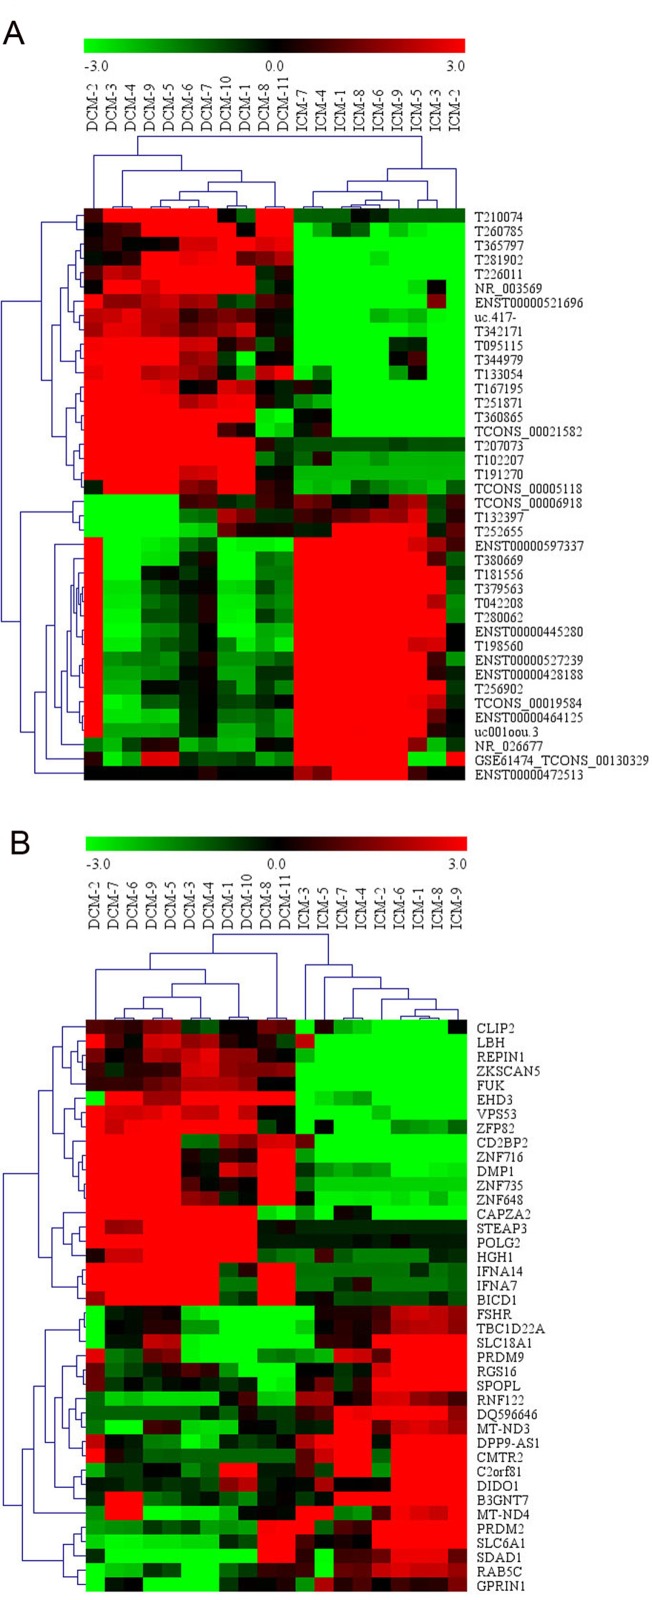
The heat map and hierarchical clustering analysis of long noncoding RNAs (lncRNAs) (A) and messenger RNAs (mRNAs) (B) that were differentially expressed between the peripheral plasma samples from dilated cardiomyopathy (DCM) and ischemic cardiomyopathy (ICM) patients. Top 20 upregulated and top 20 downregulated results were filtered with fold change (FC) ≥ 2.0 and p 0.05. Expression values are represented in shades of red and green, indicating expression above and below the relative expression respectively. −3.0, 0, and 3.0 are FCs in the corresponding spectrum. The magnitude of deviation from the median is represented by the color saturation.